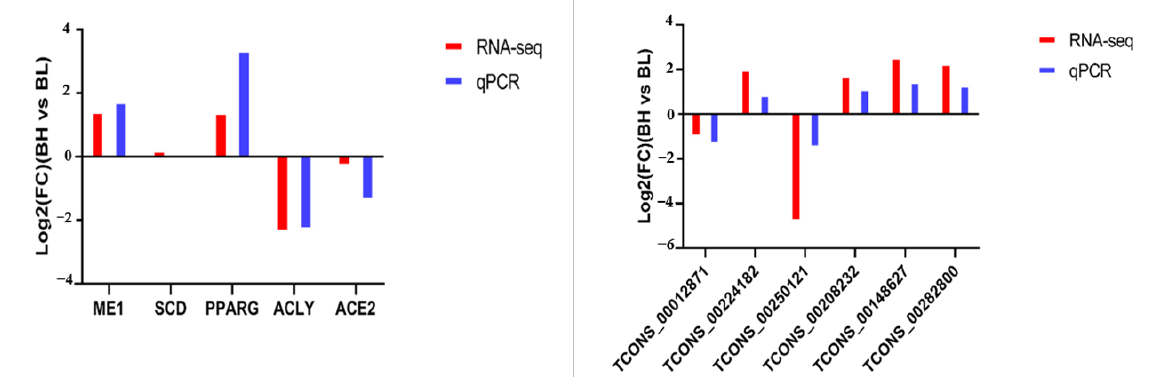
Figure 6. Validation of differentially expressed genes and lncRNAs using qPCR.